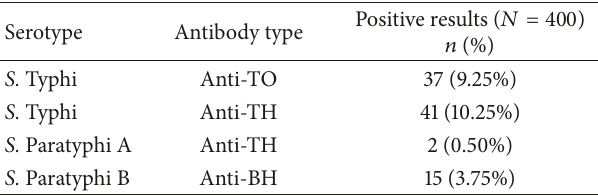
Table 2: Distribution of positive samples (antibody titre ≥ 1:40) against different Salmonella